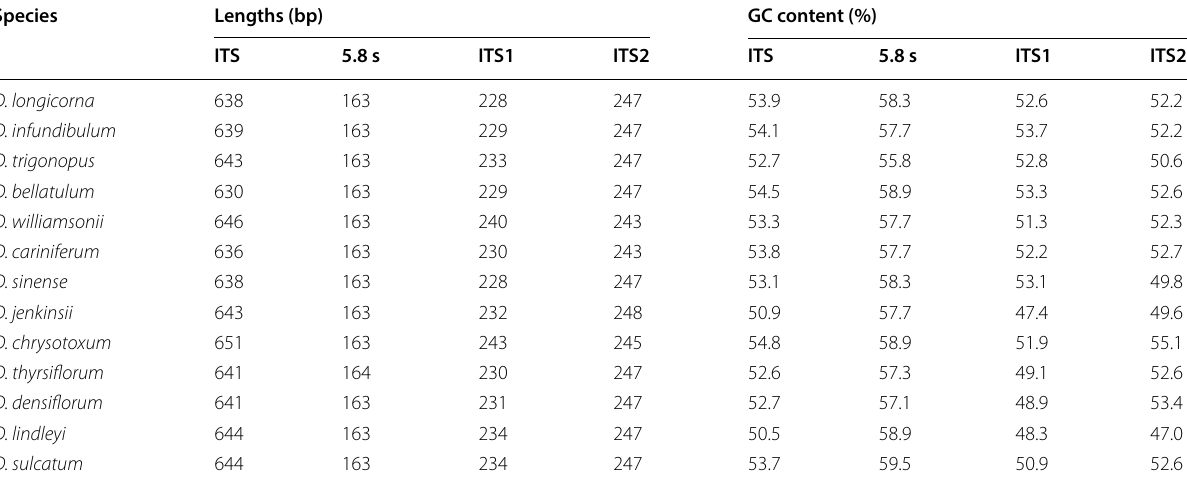
G C, guanine and cytosine + Genetic distance and phylogenetic analysis With Pholidota yunnanensis obtained from NCBI as an out-group, the genetic distance matrix and phylo- genetic tree were established based on ITS sequences (ITS1-5.8S-ITS2) of the 13 Dendrobium species and Pholidota yunnanensis , which were shown in Table 3. It could be observed that the genetic distances among the 14 species were within the range of 0.003–0.283 by the Kimura 2-parameter (K2P) model. Among the seven spe- cies of section Formsae , the range of genetic distances was from 0.003 to 0.135, and from 0.007 to 0.184 for the